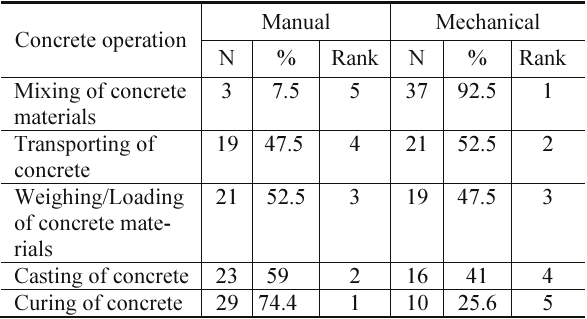
Table 4. Ranking of the levels of mechanisation of tasks in concrete operation Concrete operation